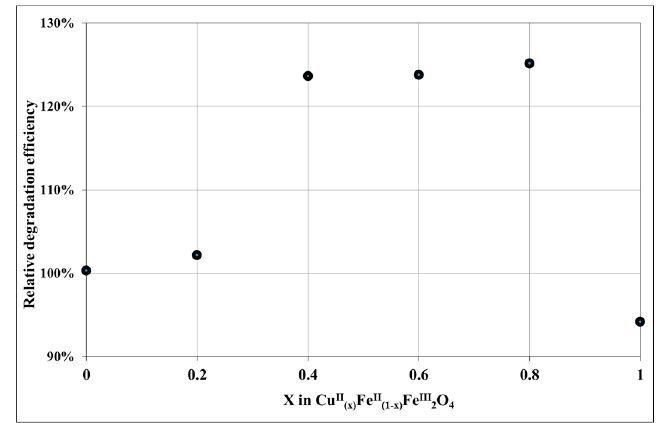
Figure 8. Relative photocatalytic efficiency (compared to the photodegradation of MB without catalysts) depending on the Cu 2+ :Fe 2+ ratio in Cu II(x) Fe II(1-x) Fe III2 O 4 . Concentrations were suggested by Singh et al. [35]: MB = 1.5 × 10 − 5 mol/L, NPs = 22.73 mg/L, initial pH = 7.5, and H 2 O 2 = 1.01 × 10 − 2 mol/L.